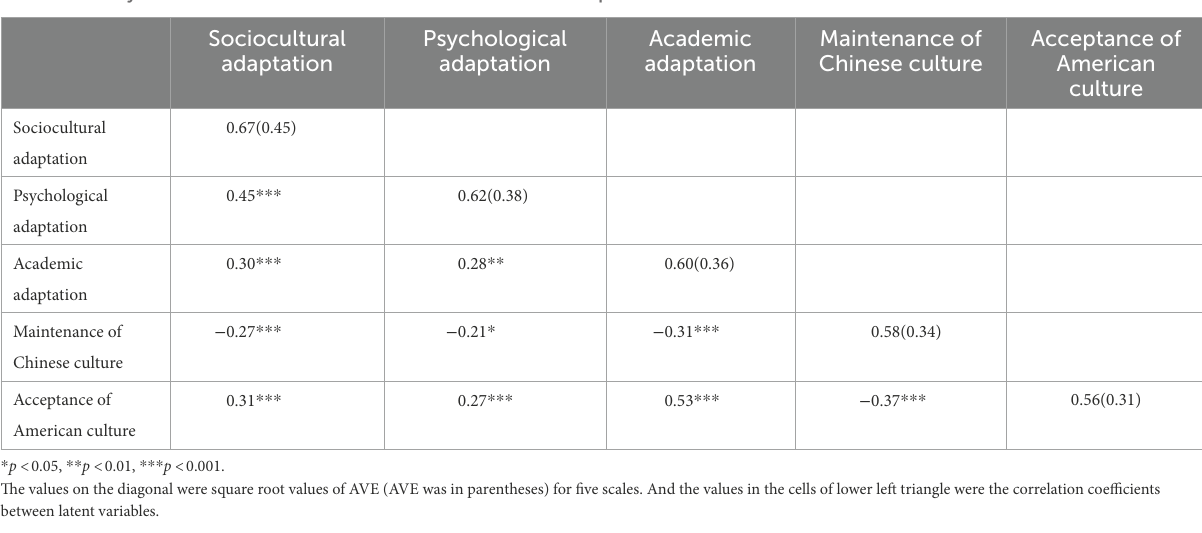
TABLE 2 Validity: Correlation coefficients between latent variables and square root of AVE.